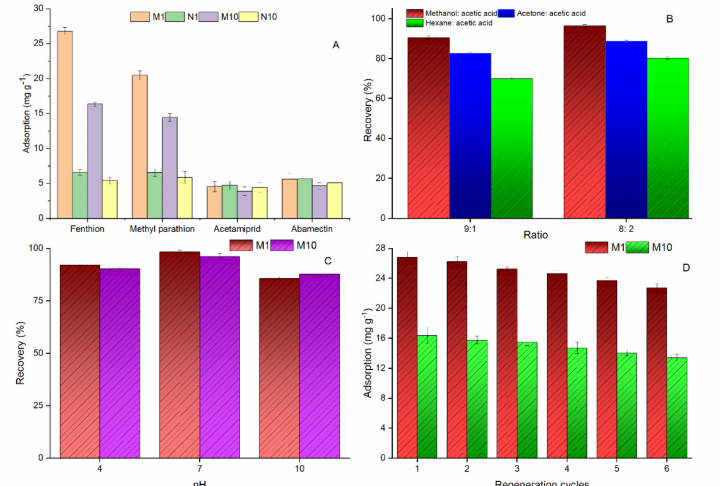
Figure 5. ( A ) Selectivity parameters of MIPs for fenthion and its competitors, ( B ) Removal of template recovery (%) with different eluents, ( C ) Adsorption response of MIPs at different pH levels, ( D ) Adsorption recoveries of fenthion by MIPs in regenerated